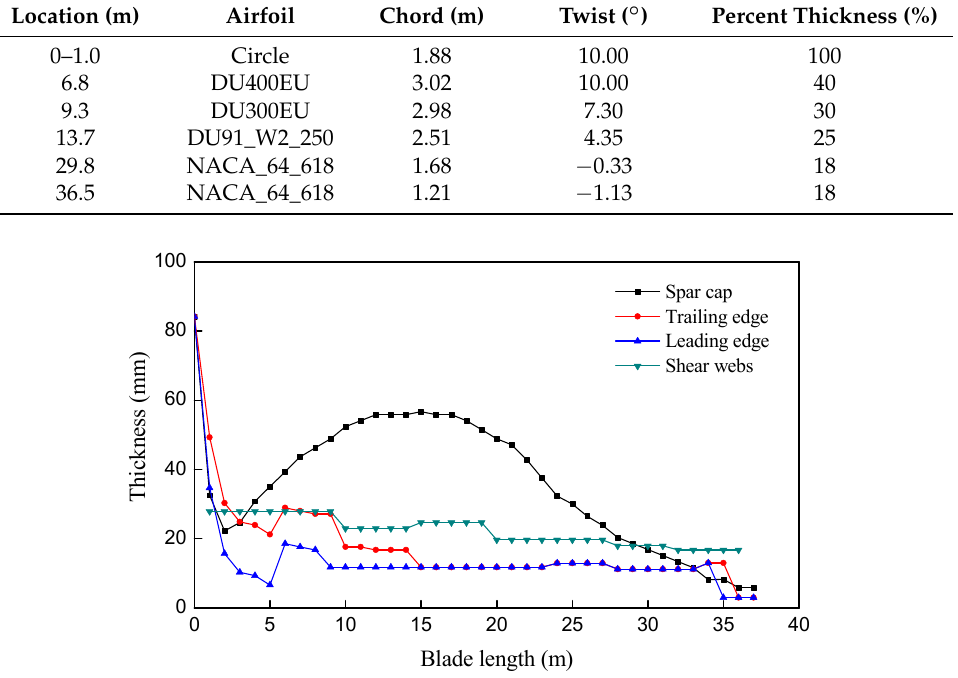
Figure 9. Thickness distribution of different parts of the blade.